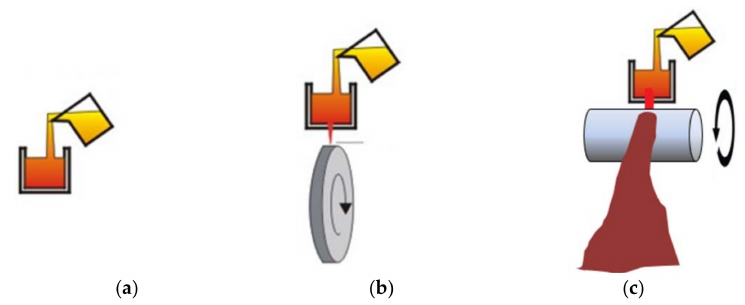
Figure 27. Schematics for ( a ) a conventional melt-and-cast, ( b ) a melt-spin, and ( c ) a strip casting MH alloy fabrication methods.